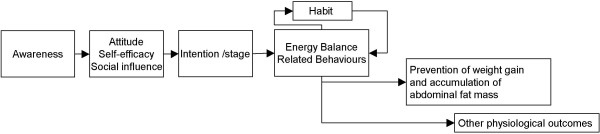
Evaluation plan (adapted from Kremers et al, 2005 [1] with permission). The intervention programme also involves awareness, attitude, self-efficacy, social influence, intention to change and energy balance related behaviours.